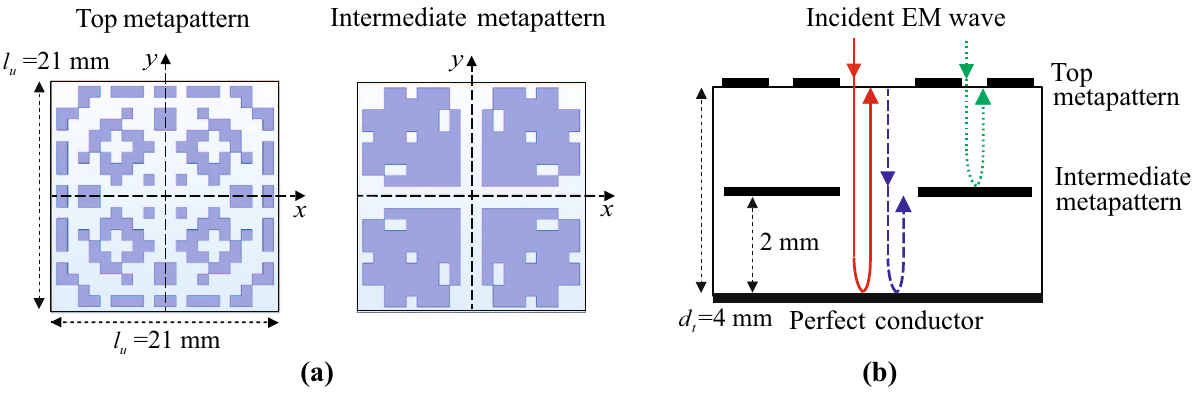
Figure 1. Schematic of metamaterial absorber composed with double-layer carbon metapatterns. ( a ) Optimized carbon metapatterns. Left-hand side: Top pattern, Right-hand side: Intermediate pattern. ( b ) Total structure and schematics of incident and reflected